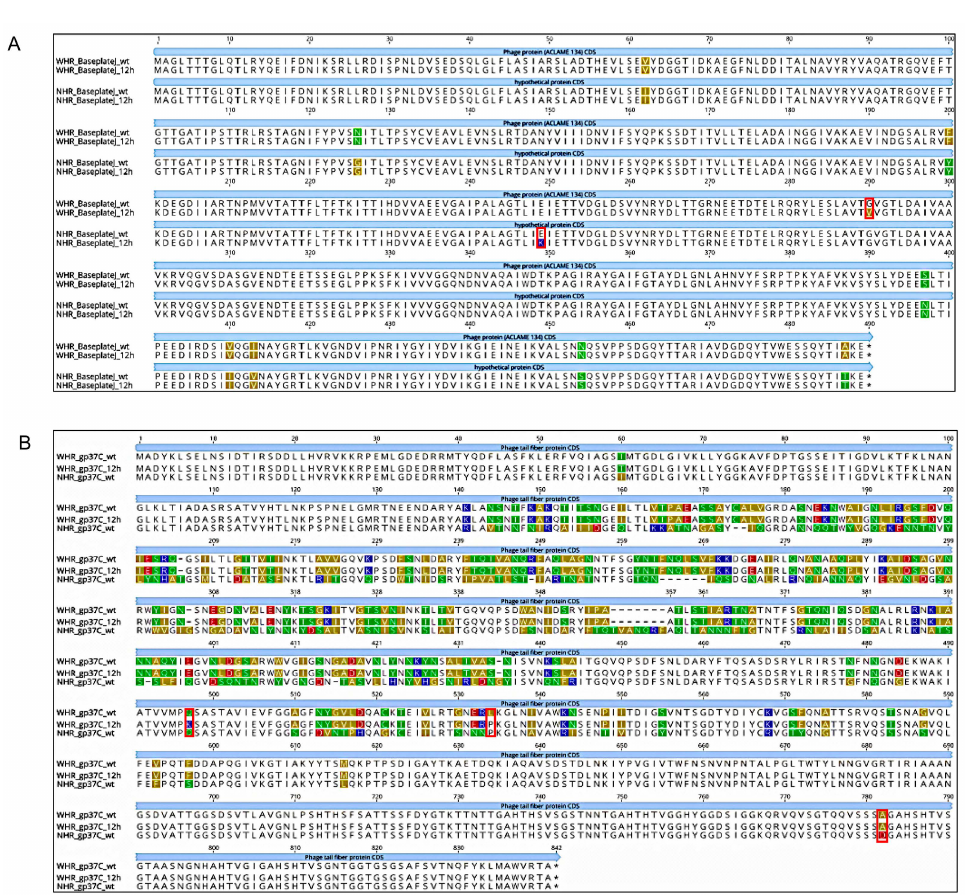
Figure 5. Amino acid alignment of baseplate J-like protein and gp37-like protein. ( A ) Amino acid alignment of baseplate J-like protein in wild-type WHR and NHR phages and WHR and NHR phages that had interacted with S. Infantis for 12 h. ( B ) Amino acid alignment of gp37-like protein in wild-type WHR and NHR phages and WHR phage exposed to S. Infantis for 12 h. The nucleotide sequences of the gene from the wild-type genomes were extracted and modified to reflect the mutation(s), then the wild-type and mutation-containing nucleotide sequences were translated and aligned with ClustalW [75] in Geneious Prime [76]. Amino acids labeled with di ff erent colors represent di ff erences among sequences of wild-type phages and the 12 h-exposed phages. Amino acid changes caused by SNPs are marked in red